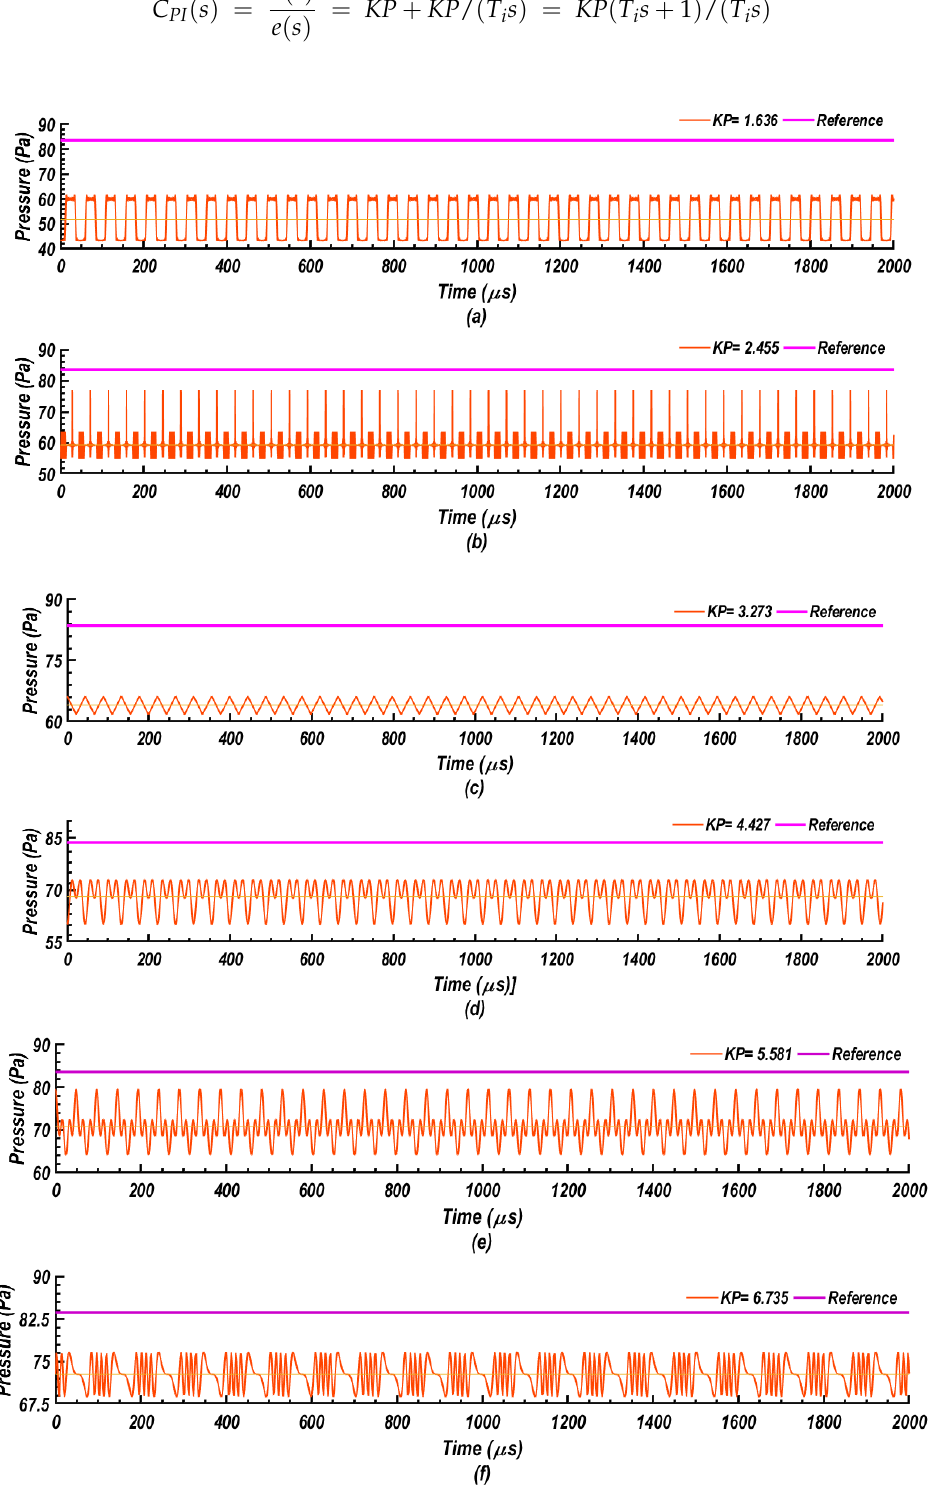
Figure 19. System responses to step changes in the command signal for a proportional controller at various gain settings. ( a ) KP = 1.636, ( b ) KP = 2.455, ( c ) KP = 3.273, ( d ) KP = 4.427, ( e ) KP = 5.581, and ( f ) KP = 6.735.